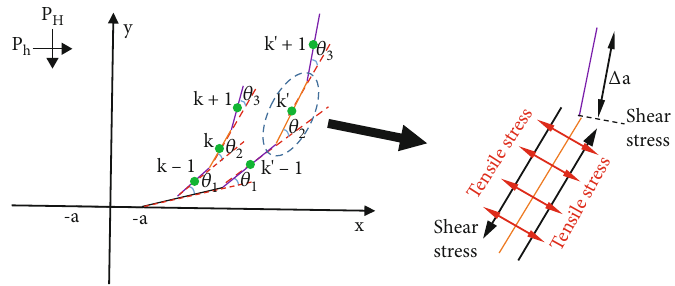
Figure 10: Propagation trajectories of HF under di ff erent length